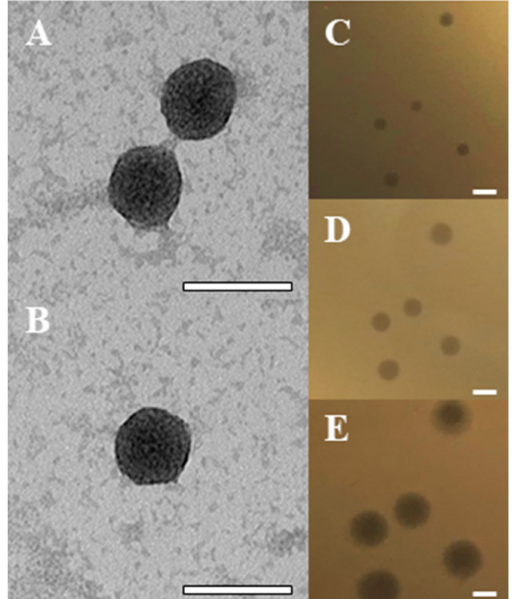
Figure 1. Characteristics of BB8 phage virions and plaques. ( A and B ) TEM image of BB8 phage virions is typical of the Podoviridae family, Caudovirales order. The scale bars in A and B represent 50 nm. ( C – E ) The growth of phage plaques over time. Plaque phenotype observed after 8, 12, and 24 h is presented in panels C – E , respectively. The scale bars in C – E panels represent 3